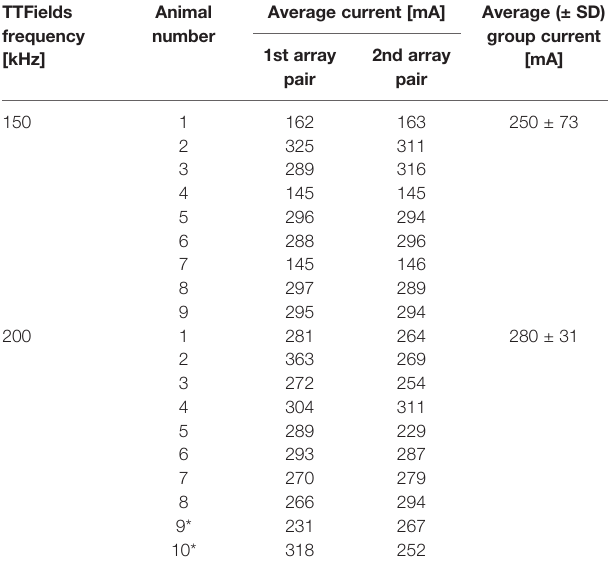
TABLE 1 | Average currents (mA) applied to each pair of arrays in healthy rats treated to the torso for 2 weeks with 150 or 200 kHz TTFields. TTFields